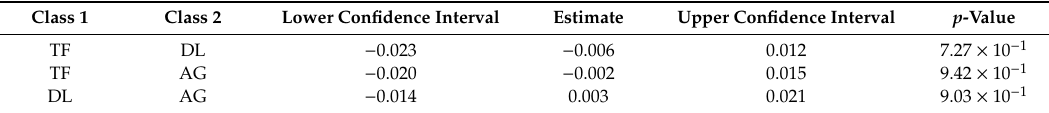
Table 5. Results of pairwise comparisons among EVI-based curve fitting methods for S. alterniflora in the YRD based on Turkey HSD